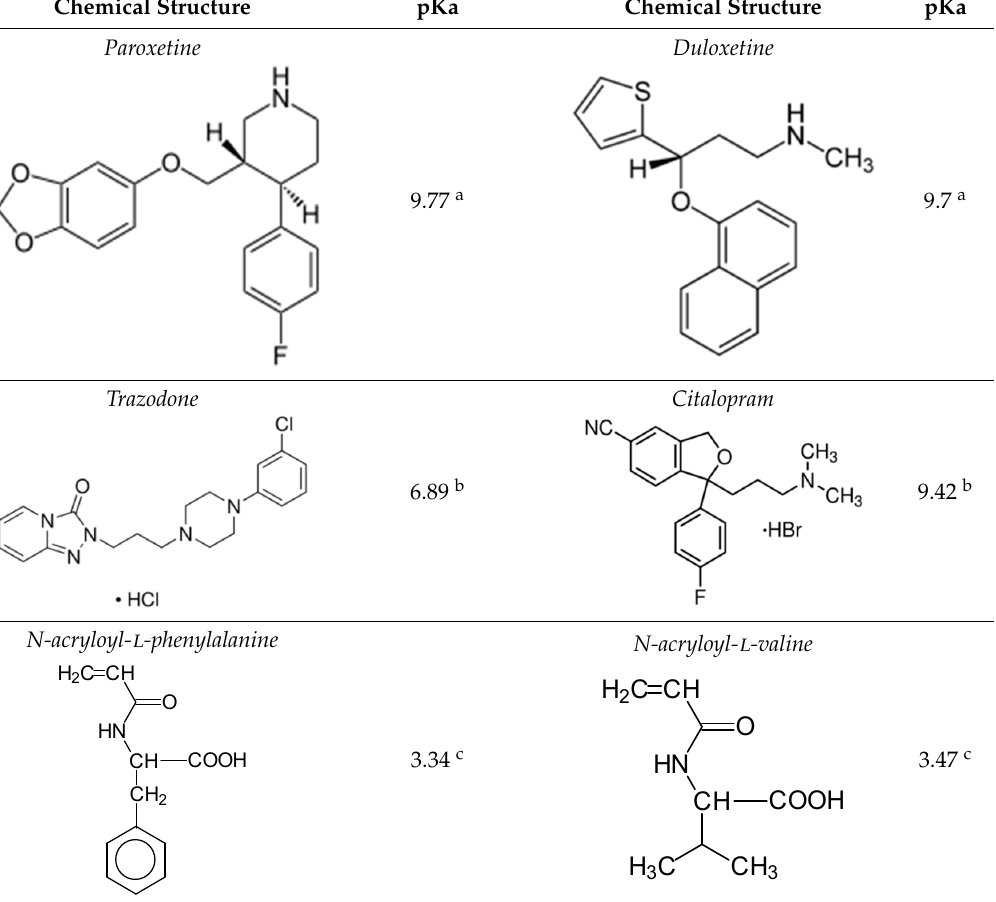
Table 1. Acidity constants of ionizable antidepressant drugs and monomers. Chemical Structure